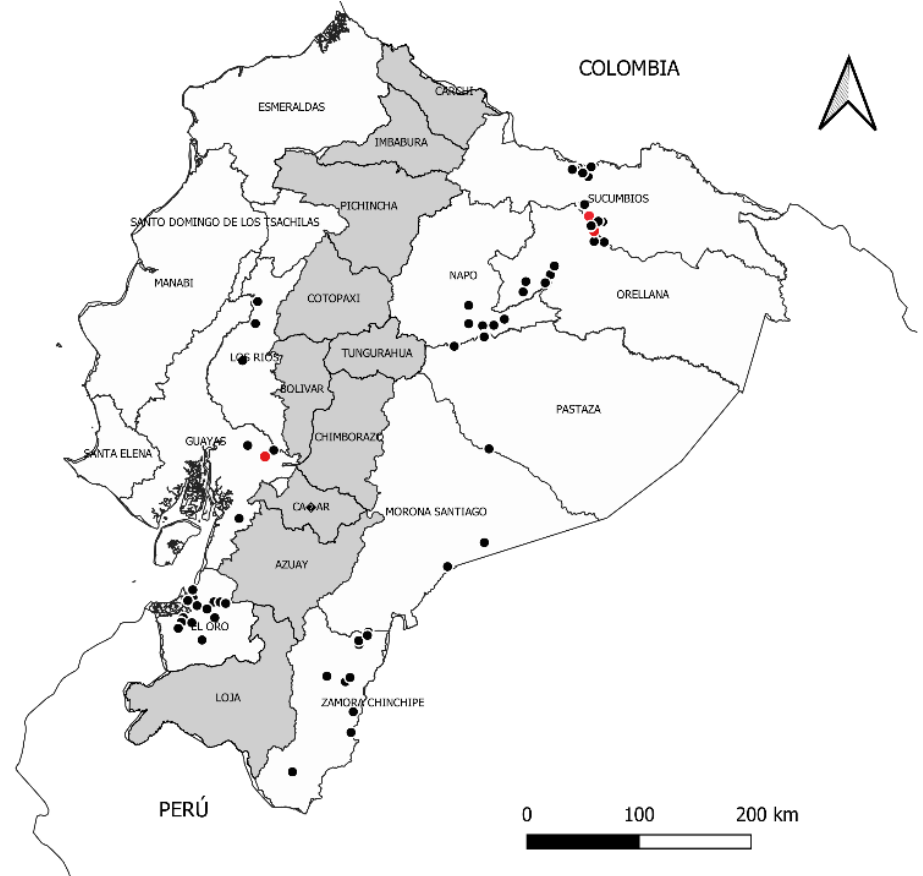
Figure 3. Spatial distribution of M. rorei isolates according to sensitivity (IC 50 ) to azoxystrobin. Red dots indicate the less sensitive, in black the more sensitive (details in Figure 2). Map of Ecuador showing the provinces of the coast ( left ), Amazon ( right ) and Andes (gray) regions.